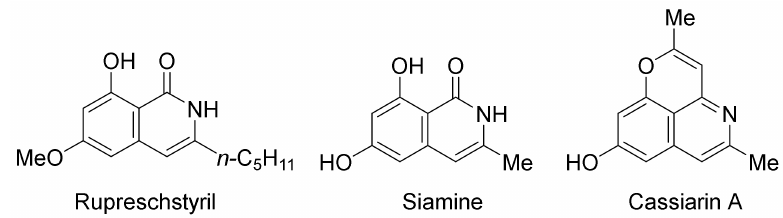
Figure 1. Synthetic applications in the total synthesis of natural